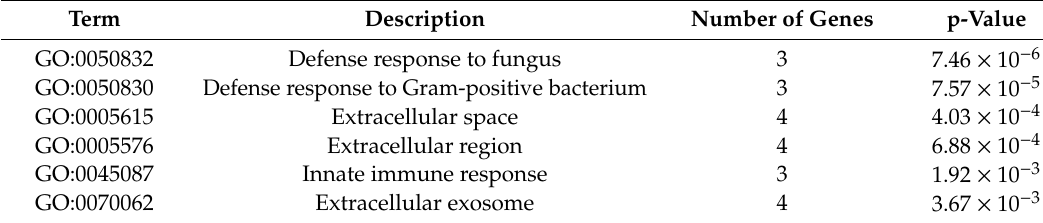
Table 6. Functional annotation clustering on cluster